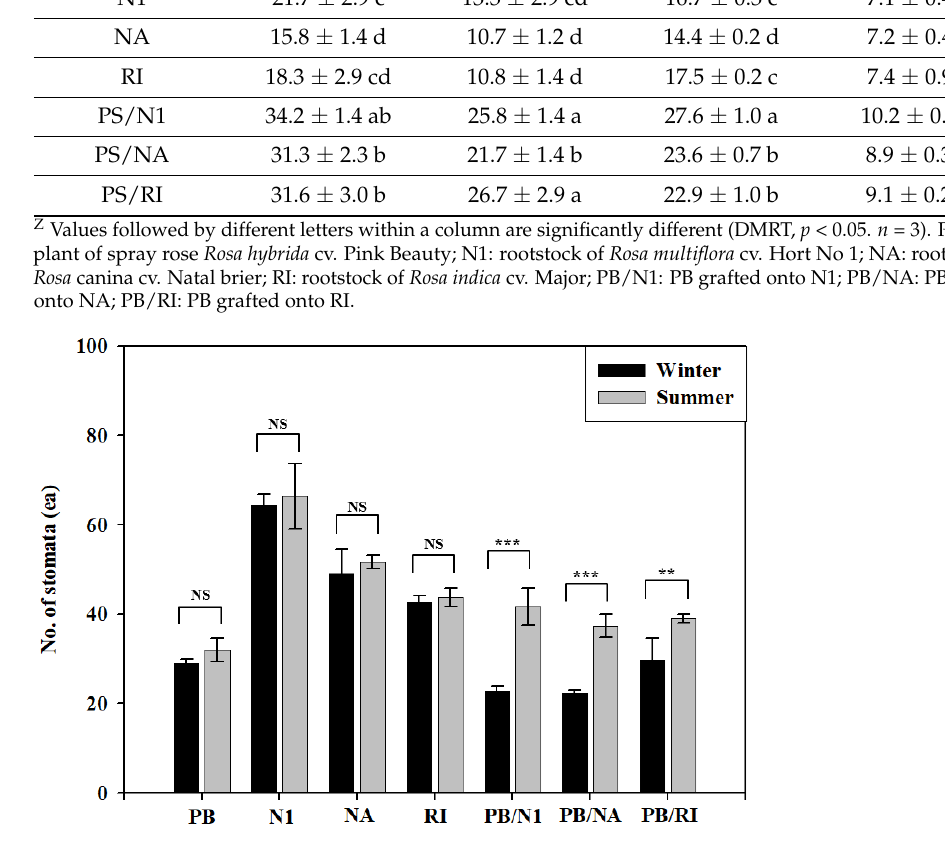
Figure 4. The stomatal number of one scion, three rootstocks, and three grafted plants measured by scanning electron microscopy. Seven-sample t-test for (PB): scion cut rose of Rosa hybrida cv. Pink Beauty; (N1): rootstock of Rosa multiflora cv. Hort No 1; (NA): rootstock of Rosa canina cv. Natal brier; (RI): rootstock of Rosa indica cv. Major; (PS/N1): PB grafted onto N1; (PB/NA): PB grafted onto NA; (PB/RI): PB grafted onto RI treatments with difference in winter and summer. NS, **, ***: not significant or significant at p < 0.01 and 0.001, respectively.